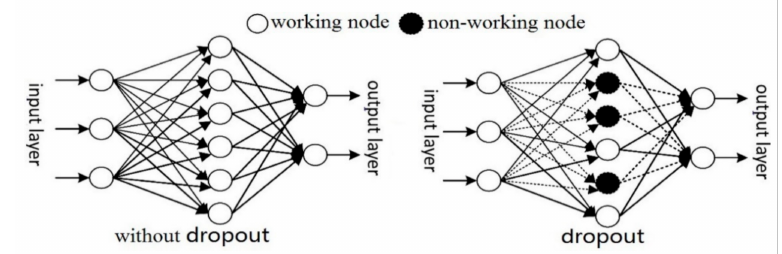
Figure 7. Dropout strategy in deep belief